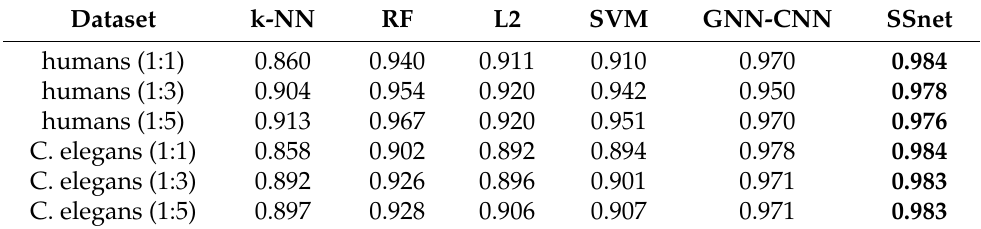
Figure 3. Model comparison on various Protein-Ligand Interaction (PLI)-specific methods with area under the curve of the receiver operating characteristics (AUCROC). The red color represents SSnet trained on humans dataset, and cyan color for C.elegans, respectively. Table 2. Data comparison (AUCROC) on balanced and unbalanced datasets.